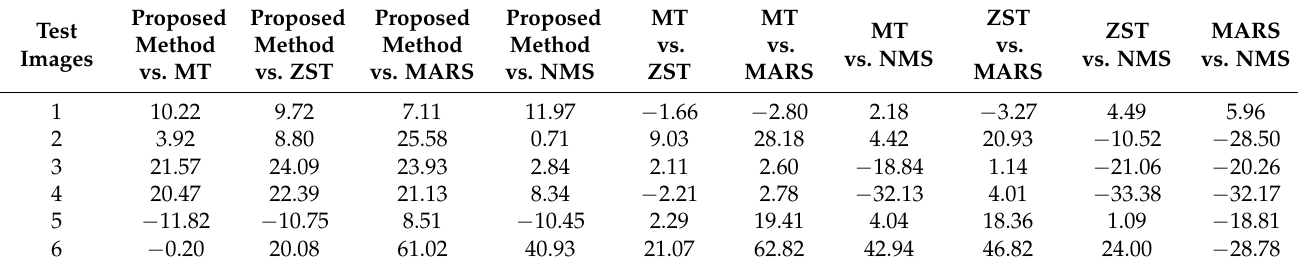
Table 5. Results of the statistical comparison ( z values) between the proposed method and the four existing methods using the McNemar tests. The positive values represent the former method having a higher extraction quality than the